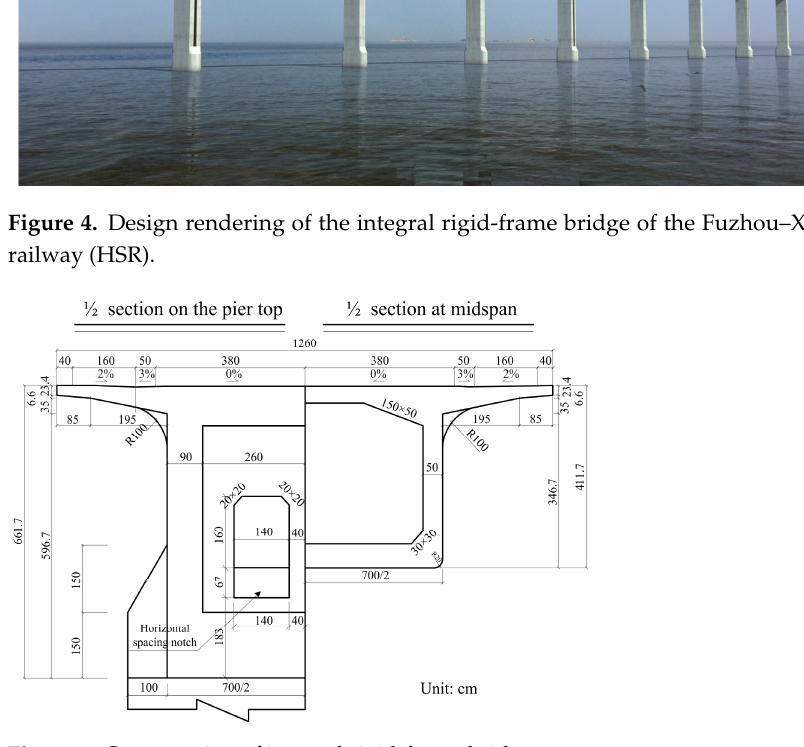
Figure 5. Cross-section of integral rigid-frame bridge.